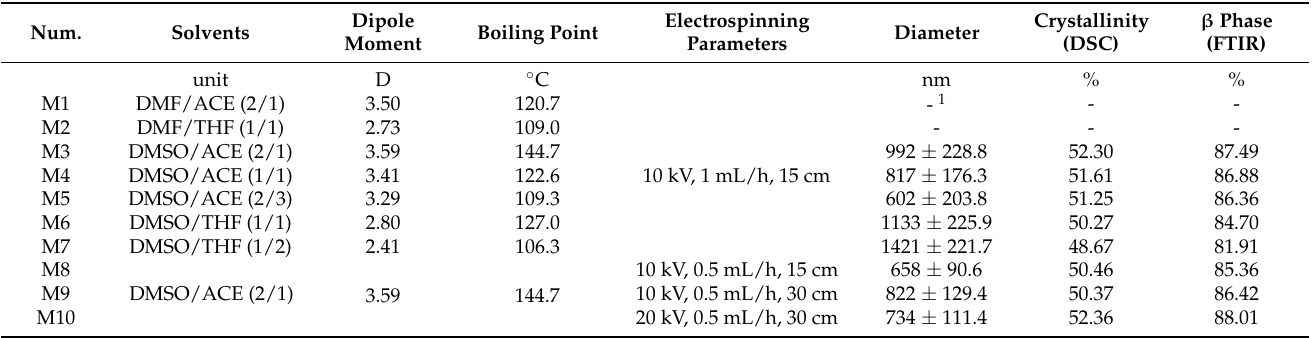
Table 3. Process parameters (solvent and electrospinning properties), nanofiber diameter, crystallinity, and β -phase fraction of the PVDF